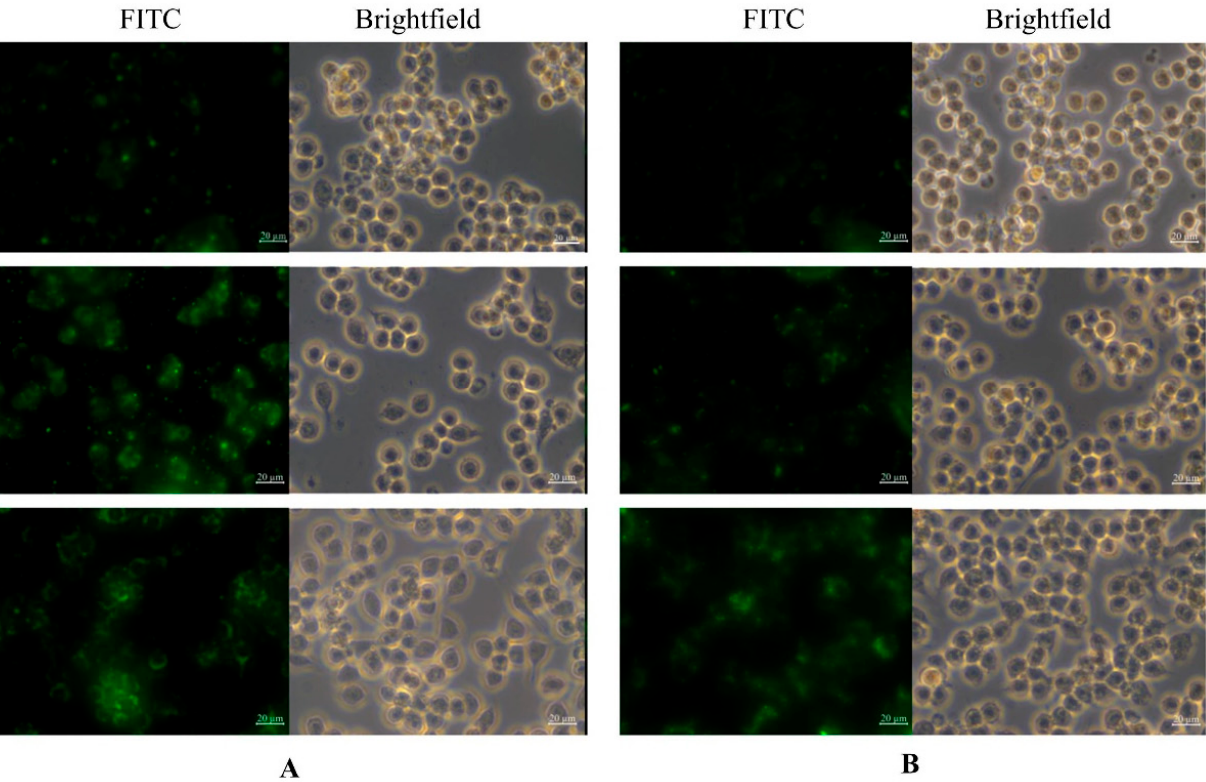
Figure 2. CLSM analysis of cellular ( A ) FITC-mSiO 2 and ( B ) FITC-mSiO 2 @PDA uptake.